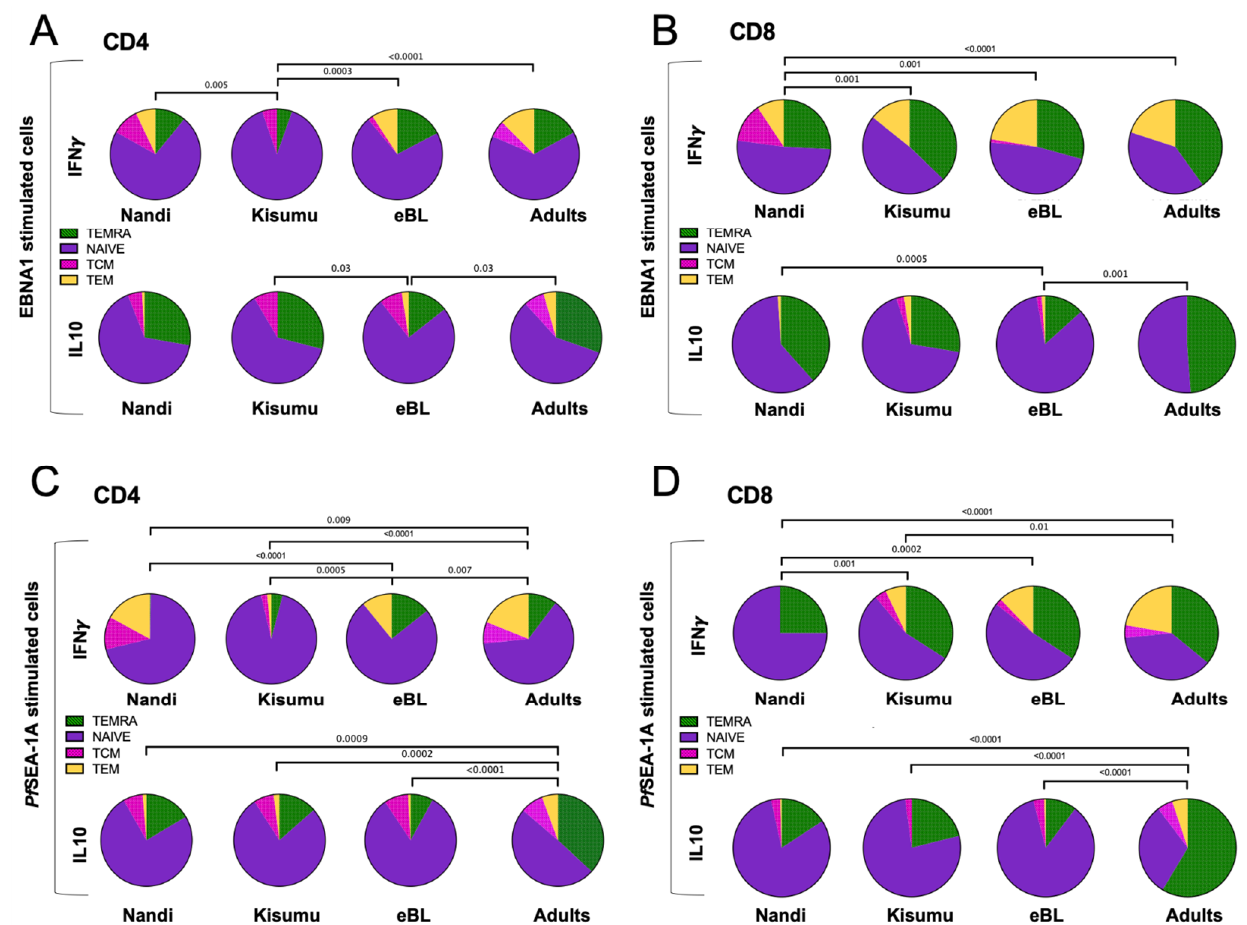
Figure 5. Comparison of EBNA1- or Pf SEA-1A- cytokine-expressing T cell subsets across groups of individuals. The mean proportion (pie slice) of IFN- γ or IL-10 expressing ( A ) CD4 + and ( B ) CD8 + after EBNA1 stimulation; or IFN- γ or IL-10 expressing ( C ) CD4 + and ( D ) CD8 + after Pf SEA-1A stimulation were compared across our study groups (Nandi, Kisumu, eBL, and Adults). T cell subsets were defined by CD45RA and CCR7 expression: T EMRA (green, CD45RA + CCR7 − ), T NAIVE-LIKE (purple, CD45RA + CCR7 + ), T CM (pink, CD45RA − CCR7 + ) and T EM (yellow, CD45RA − CCR7 − ). χ 2 test was applied and p values are indicated.